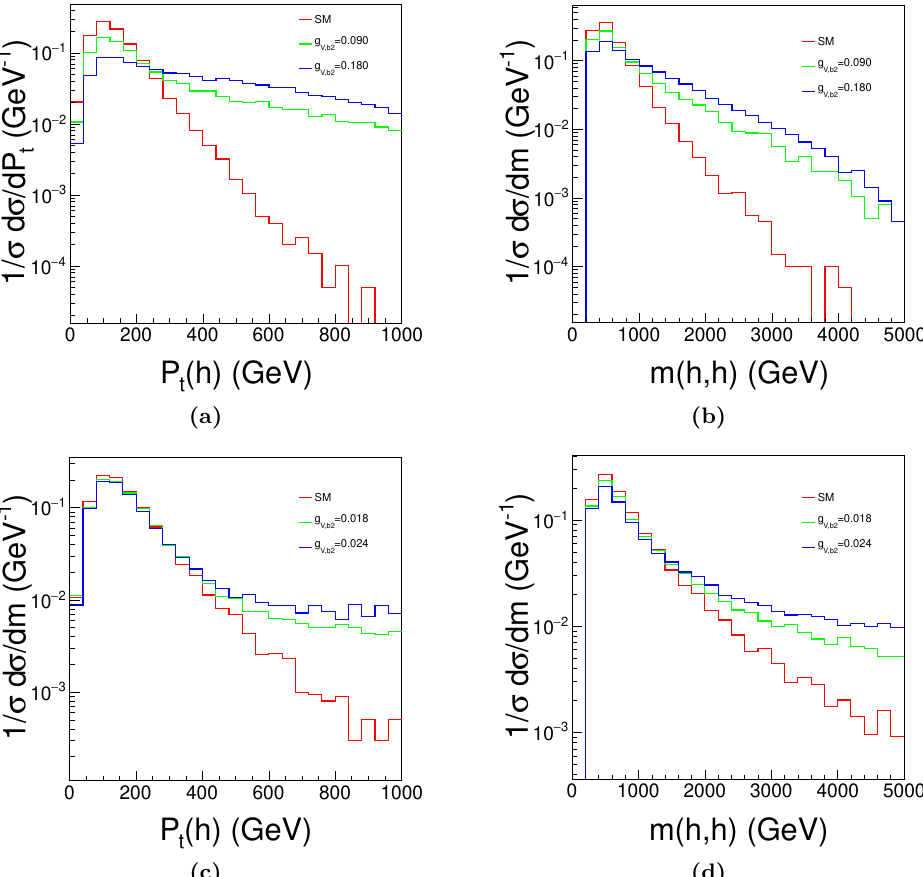
Figure 4 . Distributions of (a) the P t of the leading Higgs and (b) the invariant mass of the Higgs pair at the 14 TeV LHC, with g 100 TeV collider are shown in (c) and (d), with g